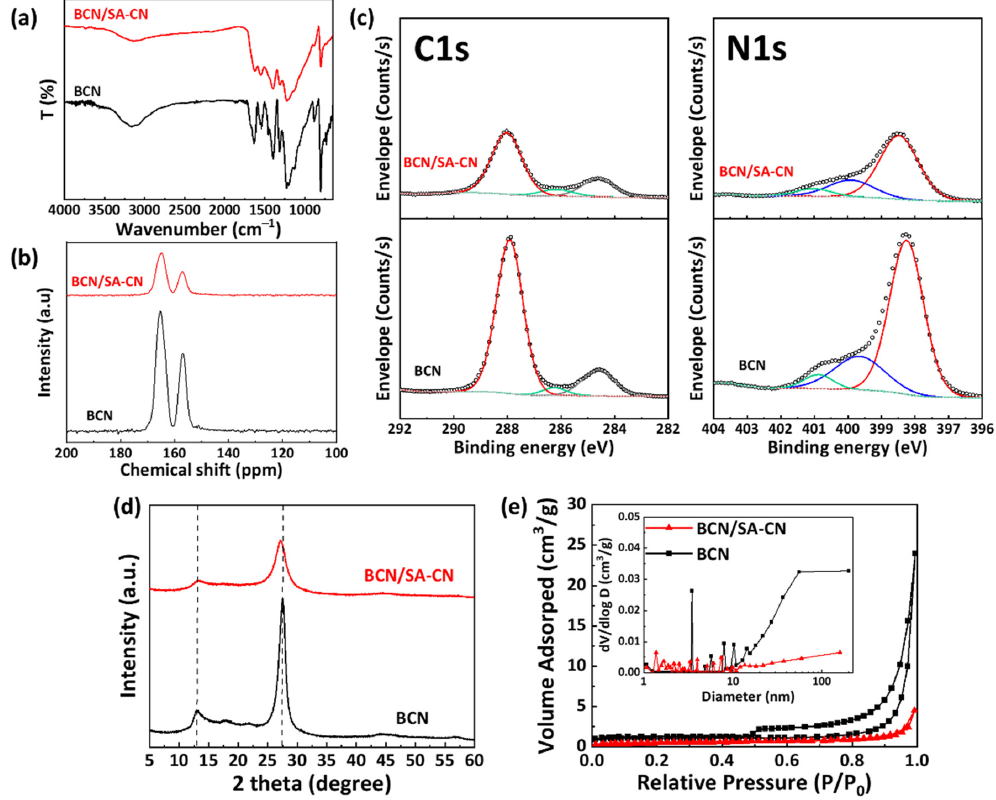
Figure 5. ( a ) FT-IR spectroscopy, ( b ) solid-state 13 C cross polarization-magic angle spinning (CP-MAS) NMR spectroscopy, ( c ) high-resolution C 1s, N 1s XPS, ( d ) powder XRD patterns, and ( e ) N 2 sorption isotherm of BCN and BCN/SA-CN. Inset of ( e ) is the pore size distribution of BCN and BCN/SA-CN calculated by the Barrett-Joyner-Halenda (BJH)